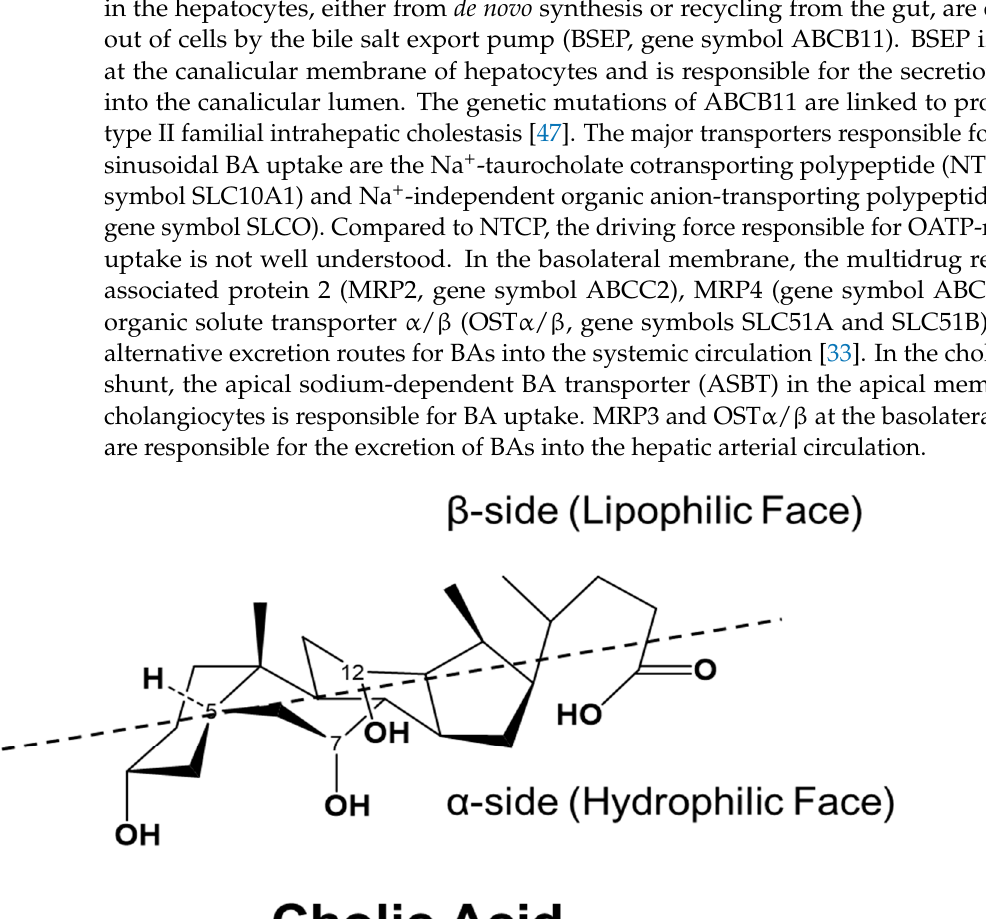
Figure 4. Bile acid transporters in hepatocytes, cholangiocytes, and ileum enterocytes.